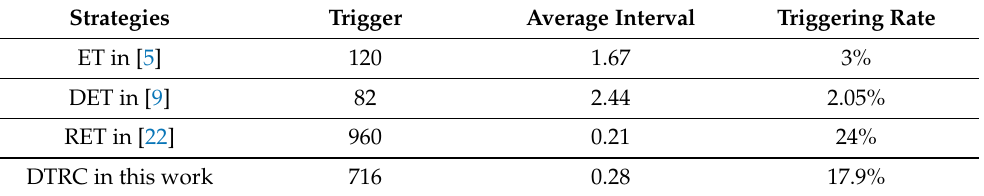
Table 1. Comparing different control